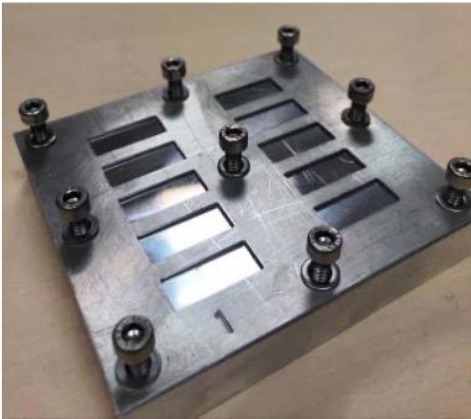
Figure 1. Metal well (1 mm thickness).